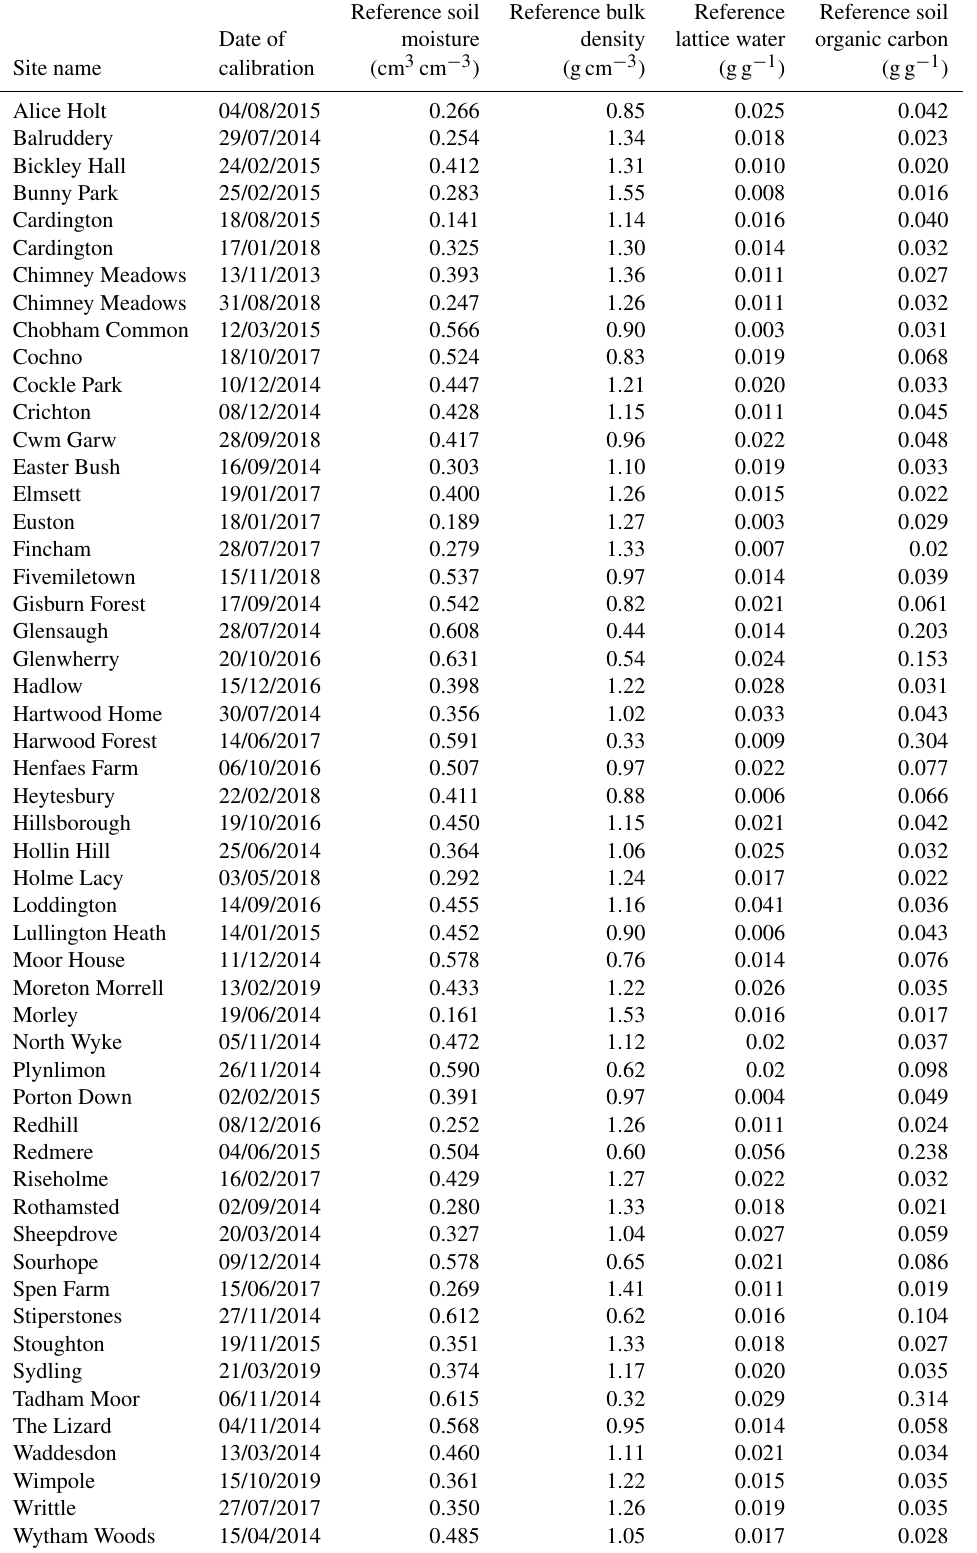
Table 5. COSMOS-UK soil sampling results. Standard deviations are available in the dataset (Stanley et al.,